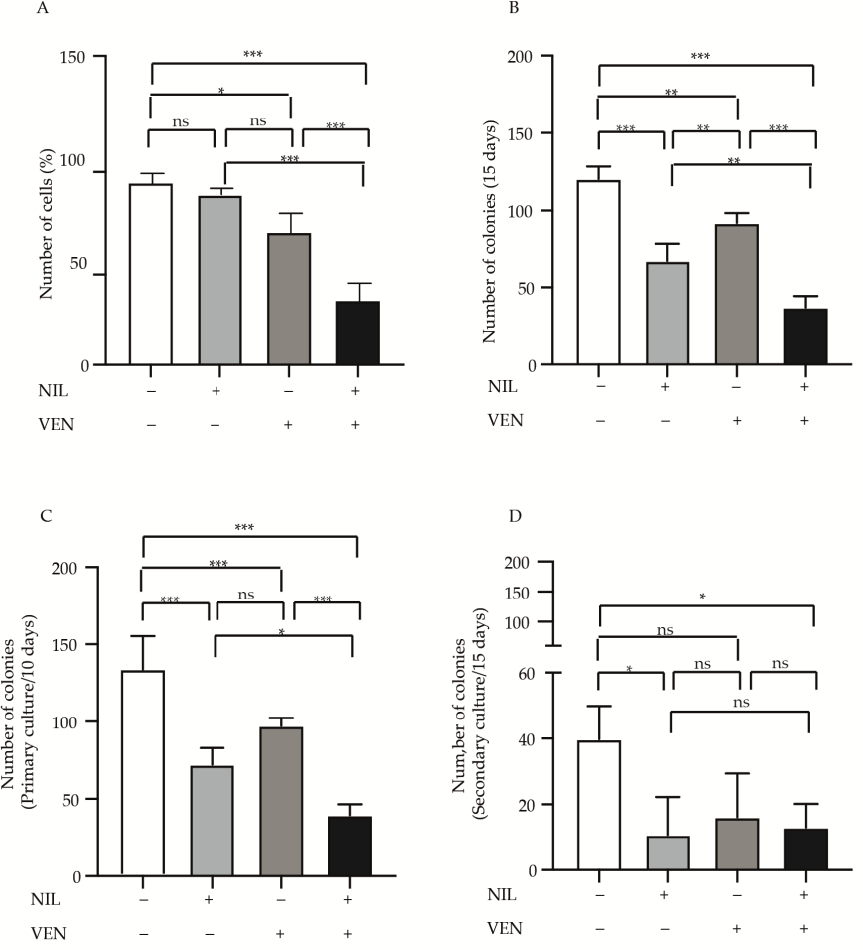
Venetoclax in committed CML CD34-positive cells. ( A ) Bone marrow CD34-positve cells derived from CML patients ( n = 4) at diagnosis, were exposed for 24 h to the indicated drugs (Venetoclax 400 nM, Nilotinib 2 µ M). Histograms report the viability of cells obtained setting arbitrary at 100% the number of cells implanted at the start of the experiment. ( B ) The same CD34-positive progenitors, treated as reported in ( A ), were implanted in methylcellulose in the presence of the same drugs regimen. Histograms report the number of colonies obtained after 15 days of culture. ( C , D ) CD34-positive progenitors treated as reported in ( B ) was used for primary ( C ) and secondary ( D ) plating performed as indicated in method. Histo-grams show the number of colonies counted after 10 ( C ) and 15 ( D ) days of culture. For all experiments, bars indicate the standard deviation derived from two experiments performed in duplicate. Statistical significance was calculated by analysis of variance (ANOVA) plus Bonferroni’s posttests ( p < 0.05 *, p < 0.01 **, p < 0.001 ***). UT = Untreated, VEN = Venetoclax, NIL =